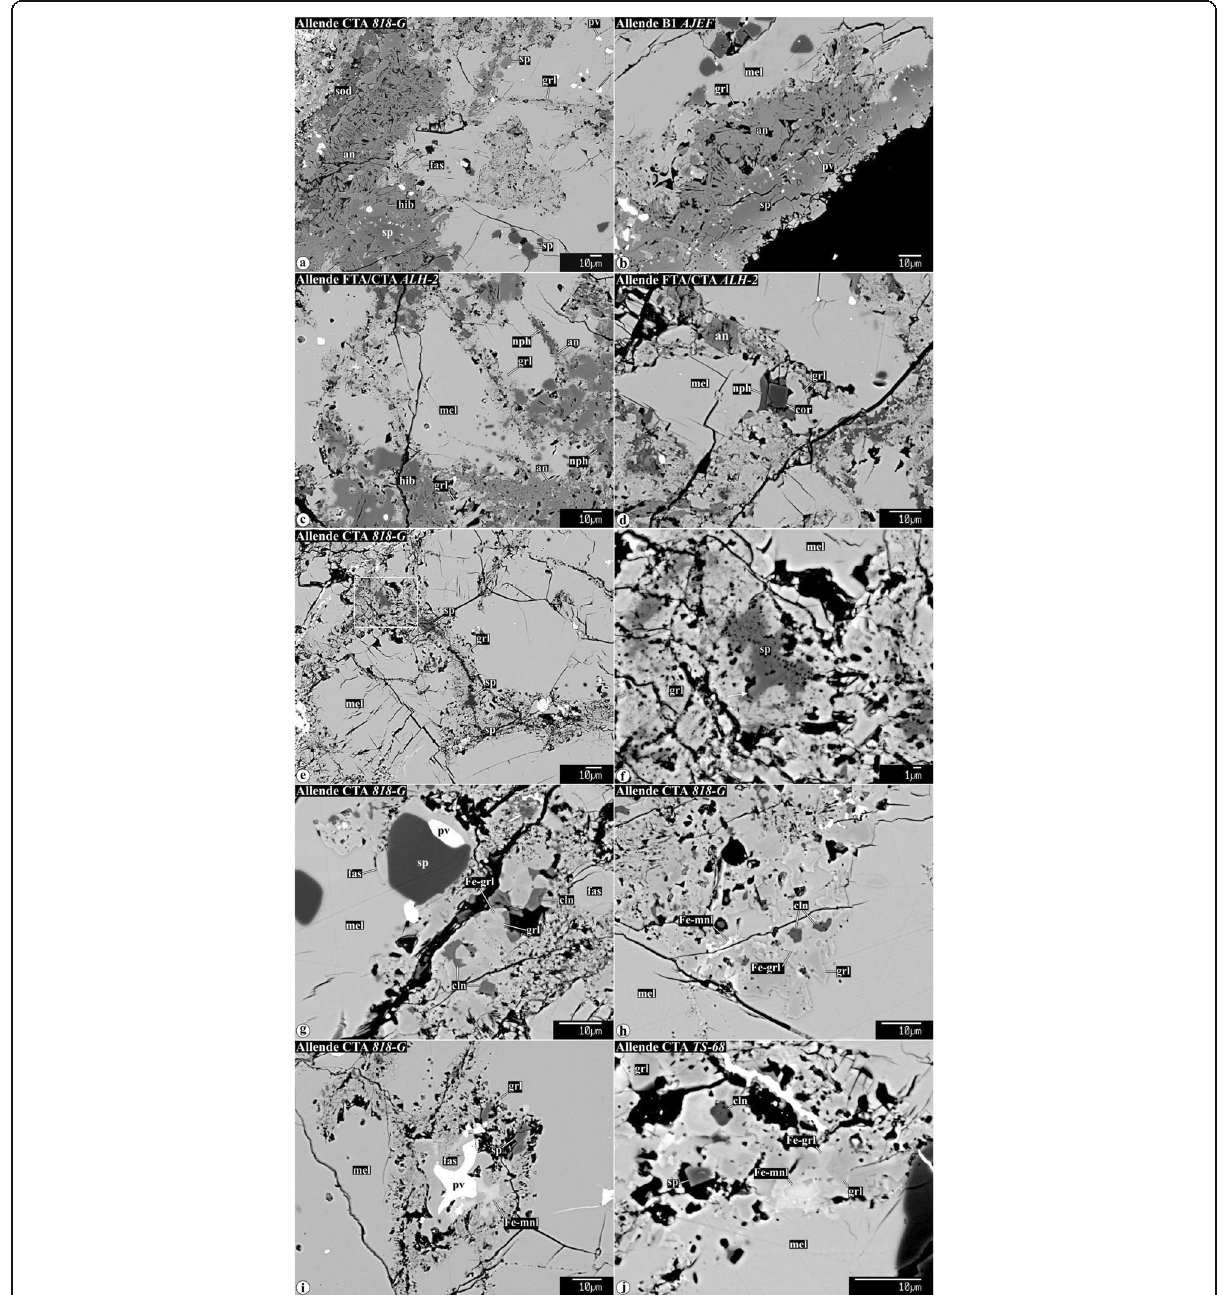
Fig. 3 Backscattered electron images of secondary minerals replacing gehlenitic melilite in CTA CAIs and mantles of Type B1 CAIs. In the CAI peripheries, melilite is replaced by anorthite and grossular. The abundance of anorthite decreases, whereas the abundance of grossular increases towards the CAI interiors. Other phases coexisting with grossular in the CAI interiors are micron-sized spinel, clintonite, FeO-enriched monticellite, and FeO-enriched grossular. The ferroan monticellite and grossular overgrow FeO-poor grossular. Clintonite is typically enclosed by grossular. Spinel grains growing into void space in veins have euhedral outlines (indicated by arrow in f ). Near the CAI edges, secondary anorthite is replaced by nepheline, sodalite, and ferromagnesian